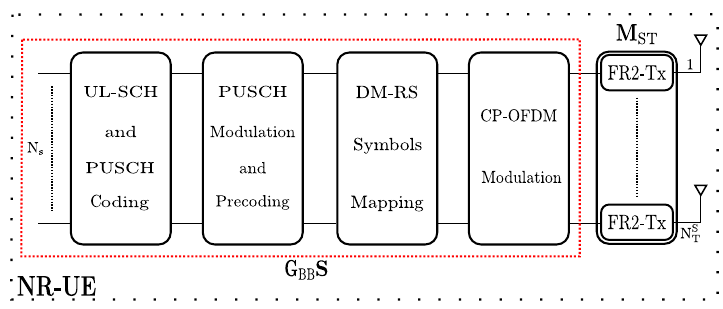
Figure 2. Baseband mmWave NR-UE